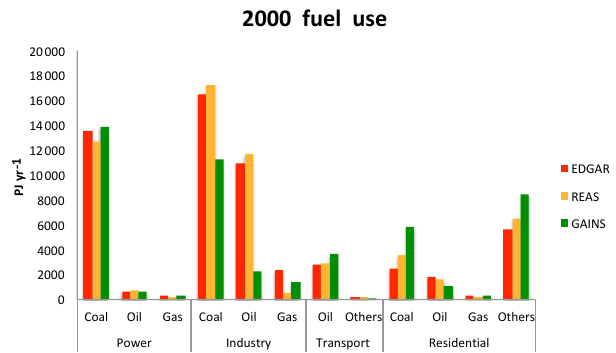
Figure 4. Total fuel use estimates by REAS, EDGAR, and GAINS for the four source sectors in